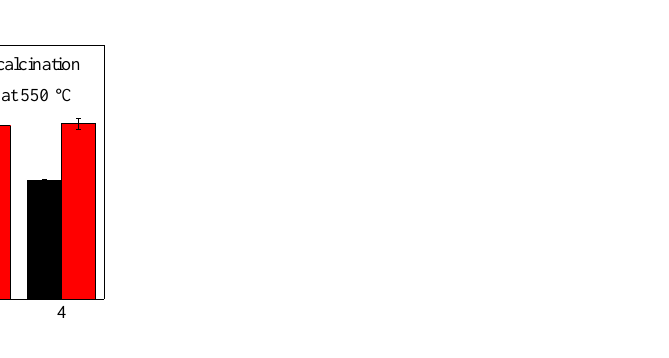
Figure 7. Stability test of c-Co 0.25 for the conversion of HFCS-55 to MLA. Reaction conditions: HFCS-55, 0.06 g; methanol, 6 mL; c-Co 0.25 , 0.03 g; 180 °C; 18 h.